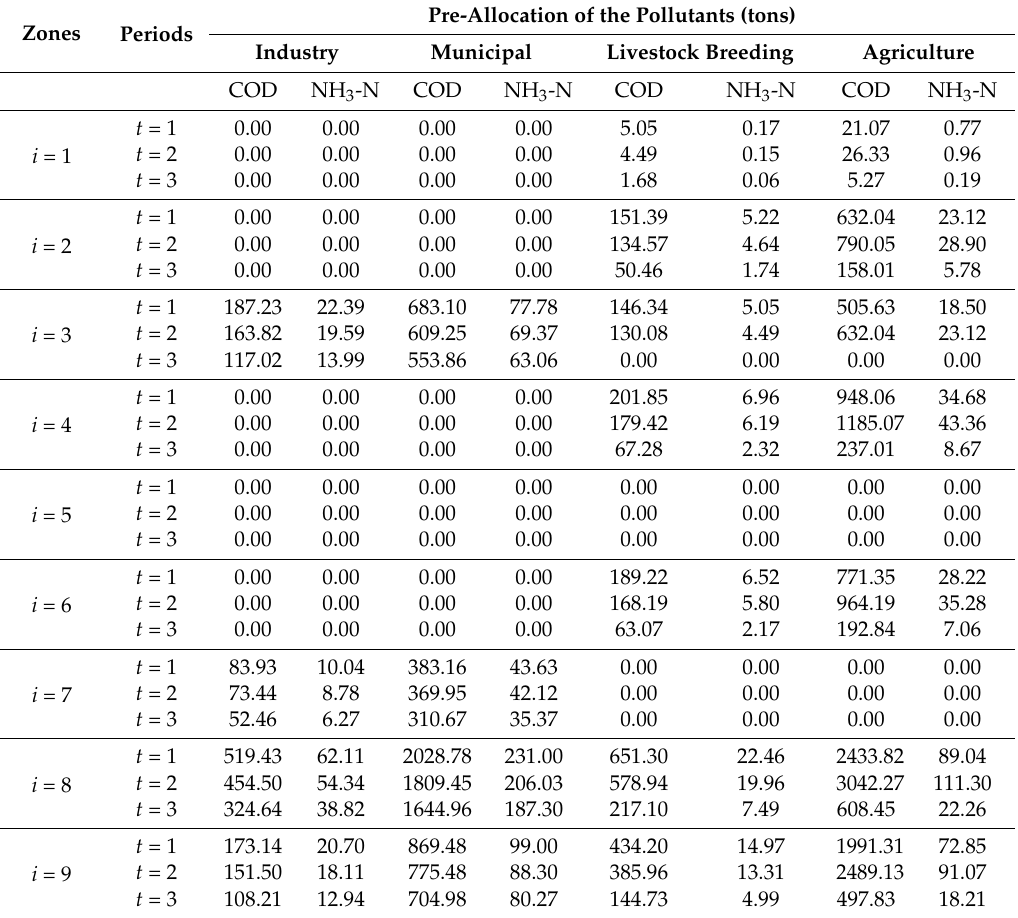
Table 3. Pre-allocation of the pollutants for different